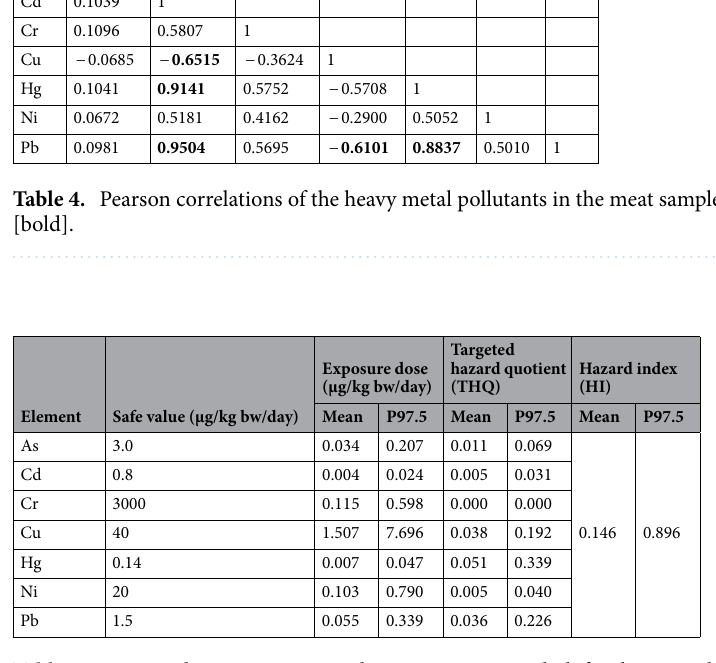
Table 5. Estimated exposure to As, Cd, Cr, Cu, Hg, Ni, and Pb for the general population in livestock and poultry meats from Zhejiang province and the health risk assessment.